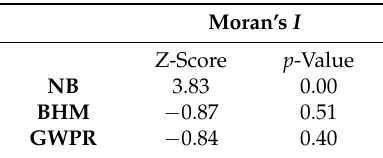
Table 4. Moran’s I Test of Model Residuals.